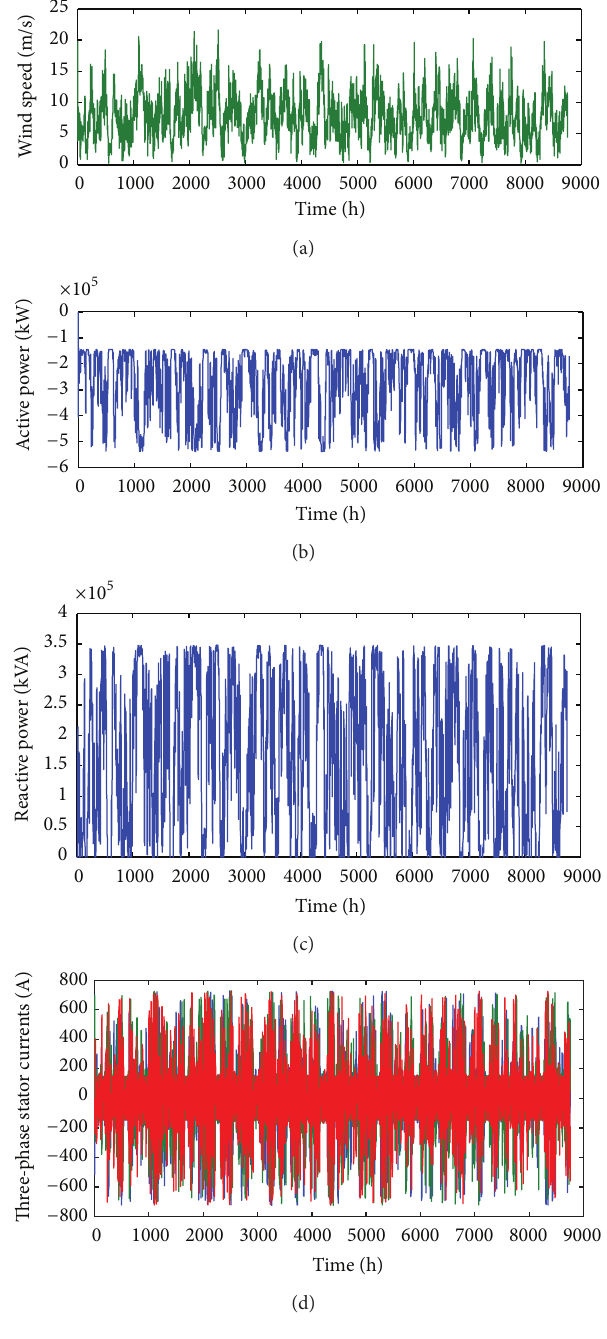
Figure 7: Simulation